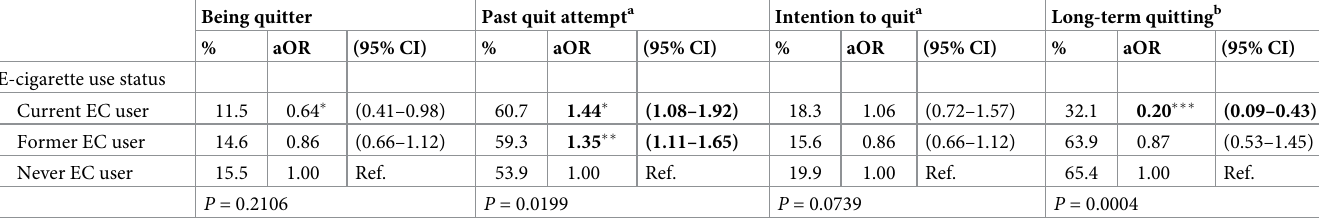
Table 3. Multivariate associations between e-cigarette use and cigarette quitting characteristics.